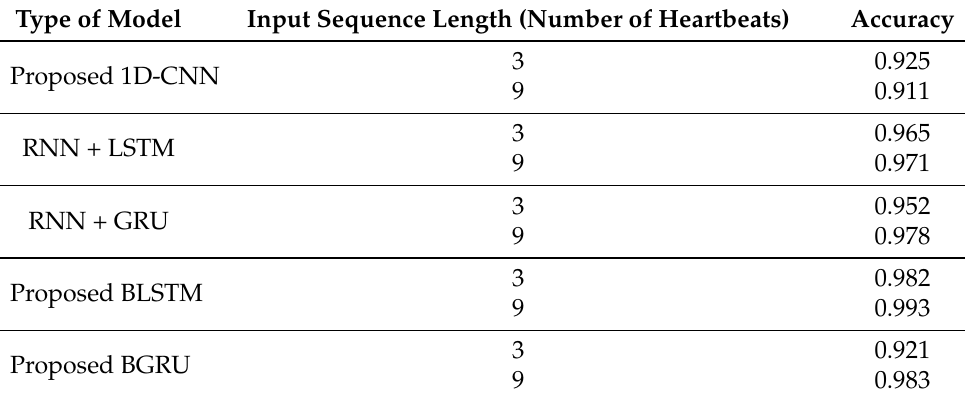
Table 3. Performance of classification accuracy for selected input sequence length over conventional and proposed models.